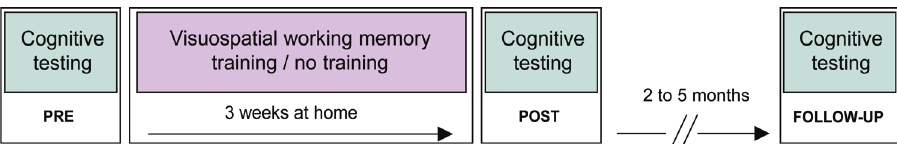
Figure 1. Timeline of the experiment and study procedure. Cognitive testing included two working memory tasks (auditory n-back and letter-number sequencing), a fluid intelligence task [matrix reasoning task, TONI-IV (Test of Non-verbal Intelligence Version IV)], two cognitive control tasks (Stroop and Flanker task), two processing speed tasks (symbol search and digit-symbol substitution task) and a short-term memory task (number-span task). In addition, subjective motivation and concentration were measured on a scale from 1 (minimal) to 10 (maximal).